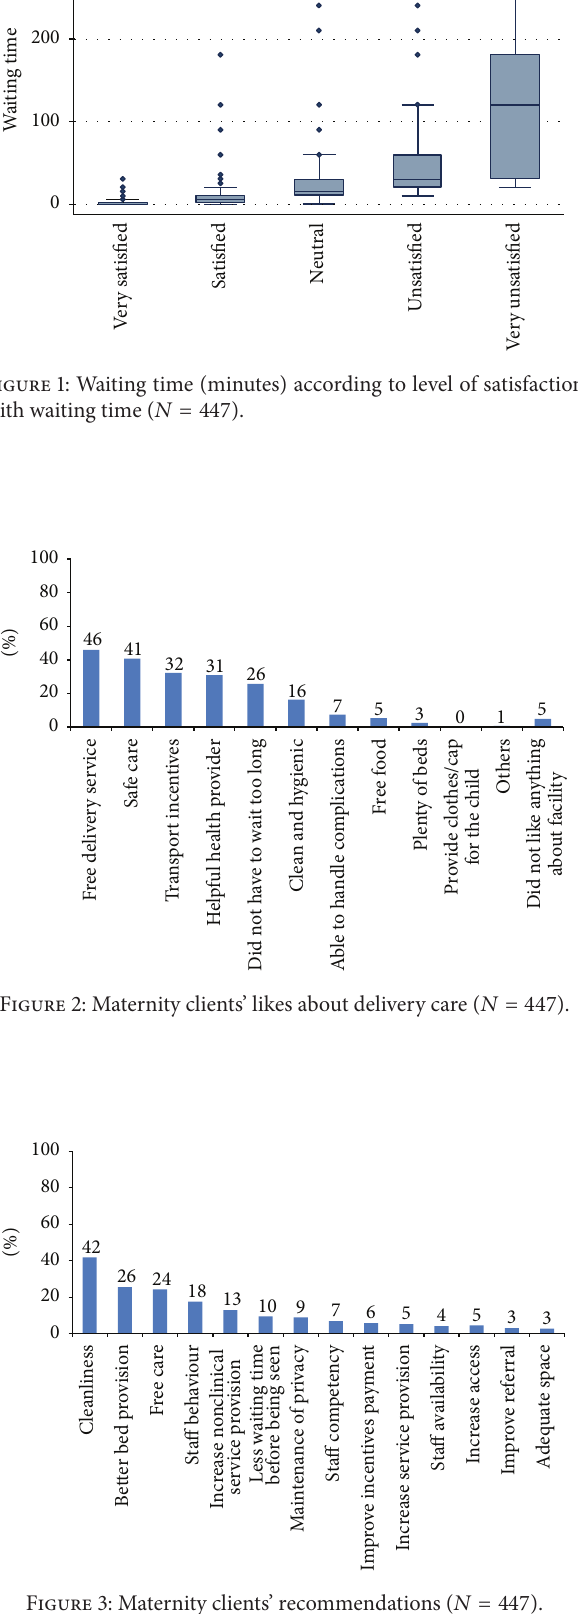
Figure 3: Maternity clients’ recommendations ( 𝑁 = 447 ).